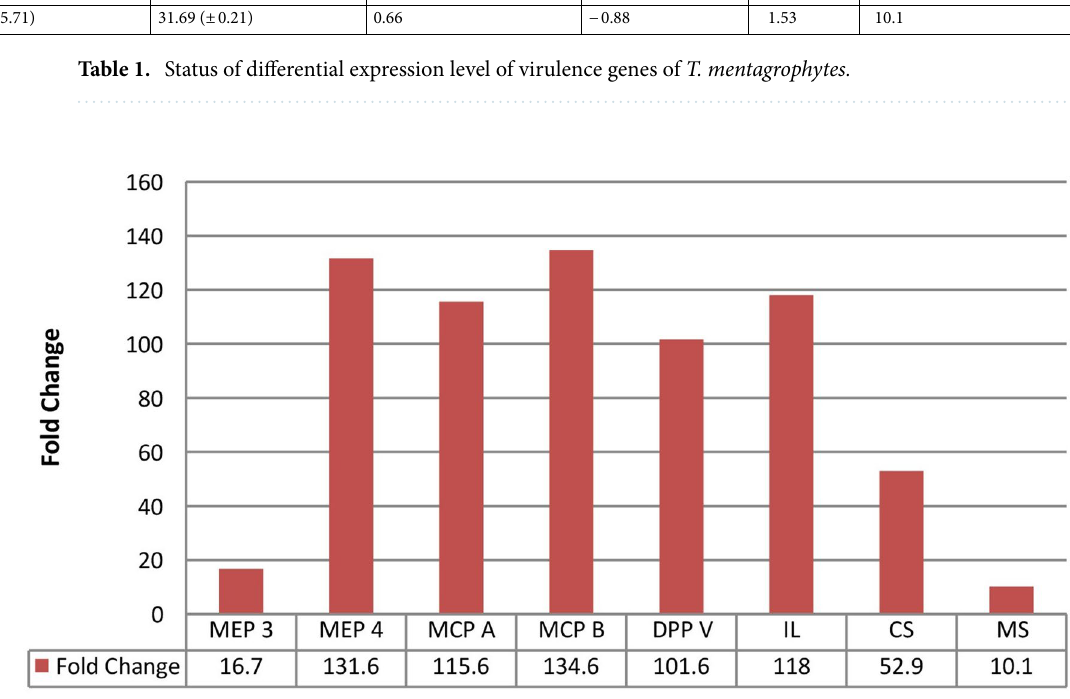
Figure 3. Fold change of all virulence genes.